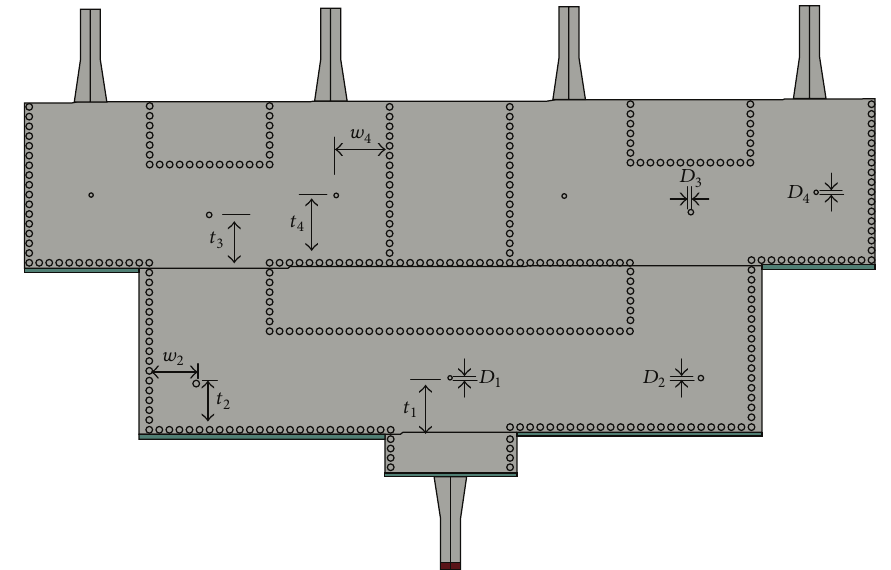
Figure 4: 4-way SIW power divider.